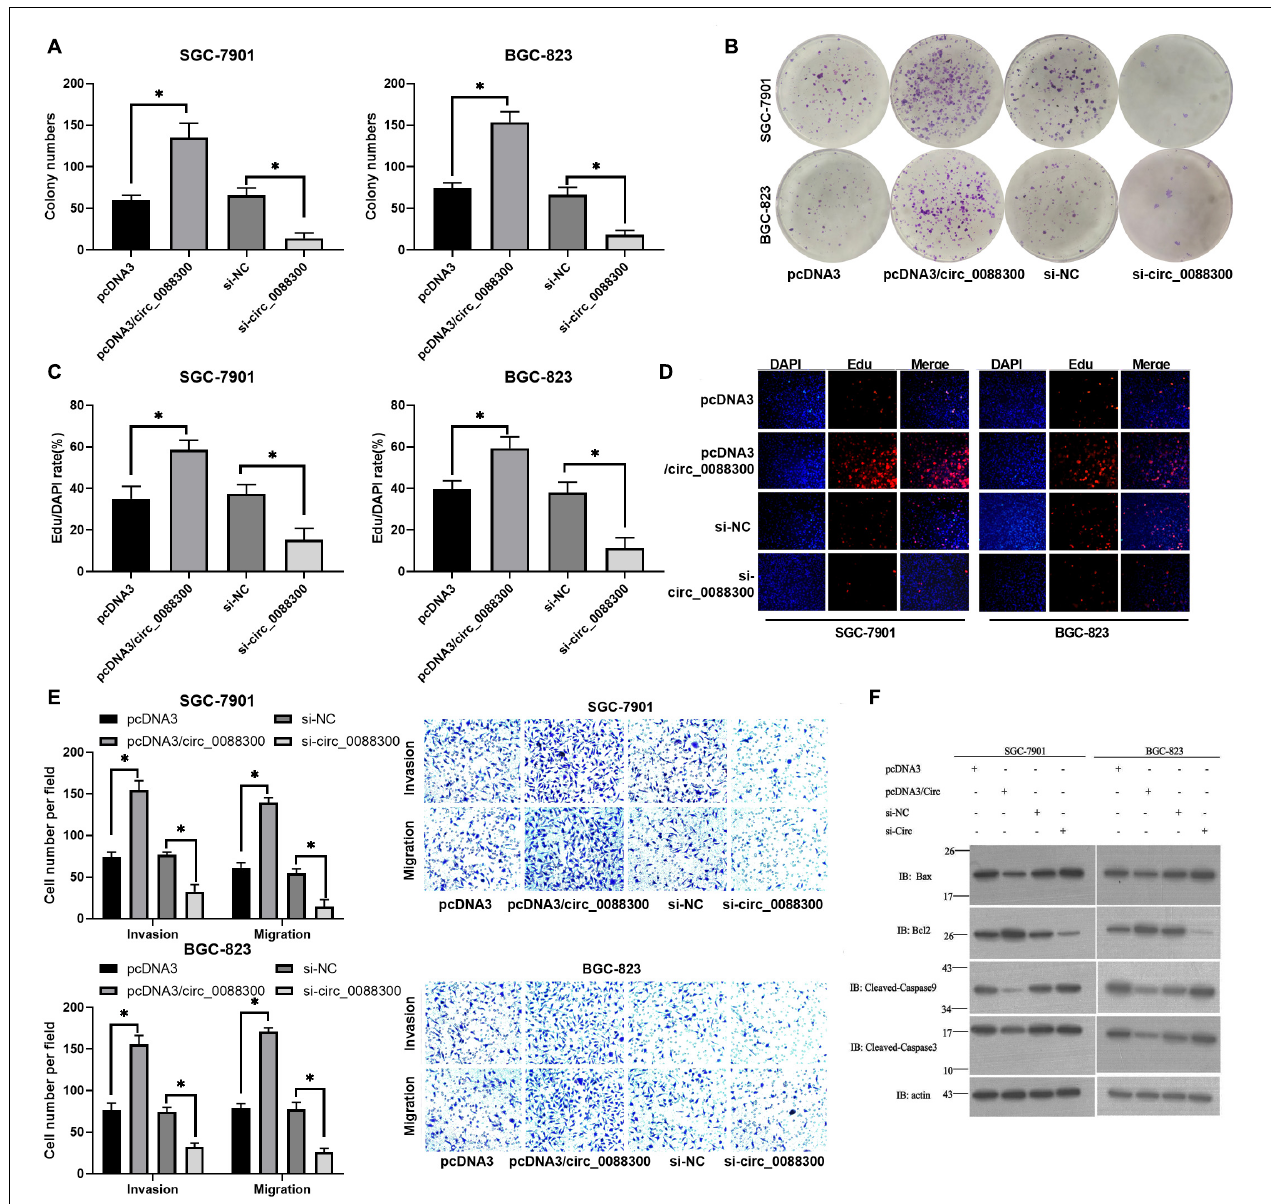
FIGURE 4 | Upregulated circ_0088300 levels enhance GC cell migration, invasion and proliferation while inhibiting their apoptosis. (A,B) Plate colony formation assays of SGC-7901 and BGC-823 cells transfected with pcDNA3/circ_0088300 or si-circ_0088300. (C,D) EdU assays of SGC-7901 and BGC-823 cells transfected with pcDNA3/circ_0088300 or si-circ_0088300. (E) Transwell assays of SGC-7901 and BGC-823 cells transfected with pcDNA3/circ_0088300 or si-circ_0088300 were performed to evaluate cell migration and invasion abilities. (F) Western blot assays were used to analyze the protein expression levels of apoptosis and anti-apoptosis proteins in GC cells ( ∗ P <